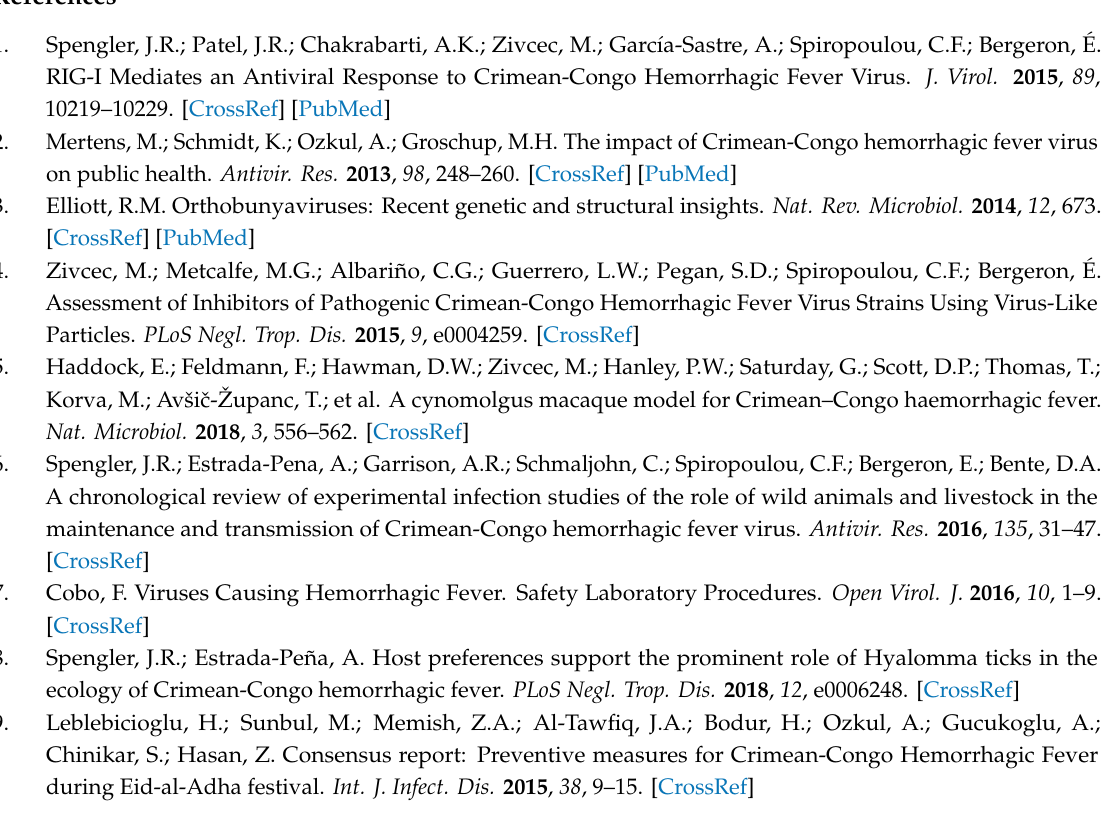
Figure A1. Viral load of CCHFV through three serial passages in immortalized and primary kidney and human cells. Each cell line was inoculated in T25 flasks in triplicate up to twelve days until cytopathic effect reached about 80%. After three rounds of freeze-thaw, the cellular debris was removed by centrifugation at 3000 rpm for 10 min at 4 °C and the supernatants were collected. This procedure was repeated two more times. The virus was titrated between each passage using a standard TCID50 assay in SW-13 cells. Genomic viral load decreased by time more than two-log in bovine cells, while it fluctuated only one-log in human cell lines. All calculations were based on log- transformed viral loads (copies/mL). Mean and SD were calculated by triplicate measurements.